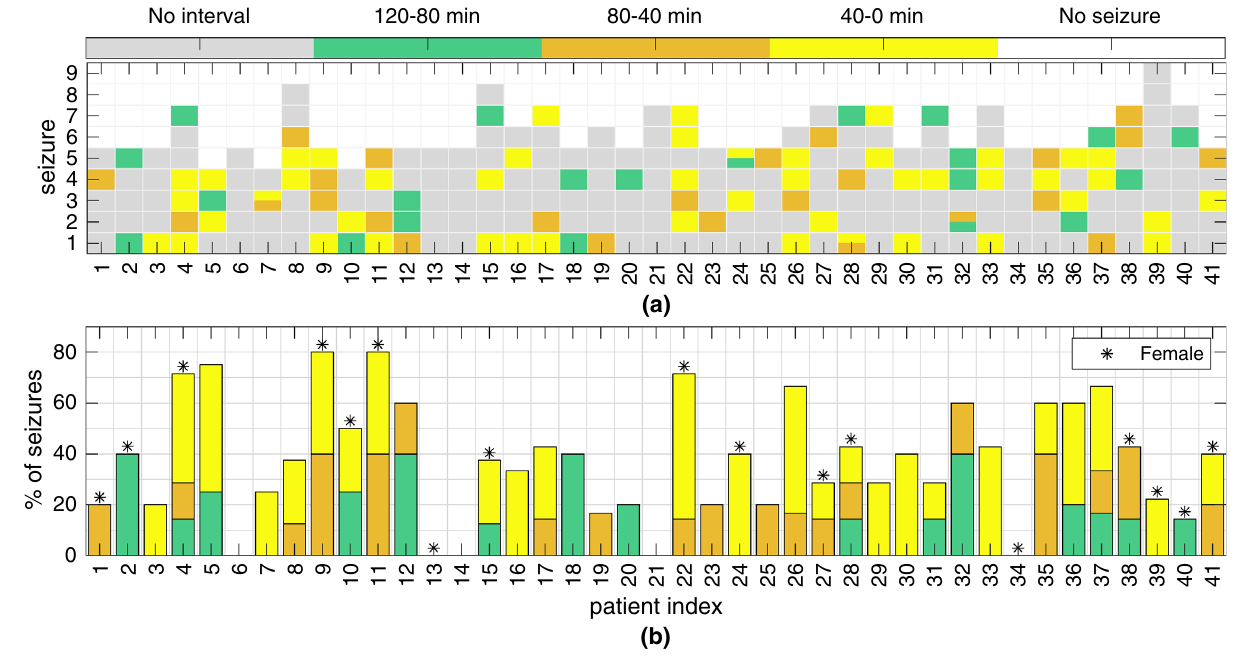
Figure 4. Results of the stratification and selection of clustering solutions based on time continuity and duration. ( a ) Information regarding the existence of clustering solutions for each patient (x-axis) and each seizure (y-axis, in chronological order) for the three different intervals considered: 120–80, 80–40 and 40–0 min before seizure onset (occurring at 0 min). There were four seizures (third seizure in patient 7, fifth seizure in patient 24, first seizure in patient 28, and second seizure in patient 32) for which clustering solutions were found in more than one interval. ( b ) The percentage of seizures for which at least one clustering solution was found is depicted for each patient and each 40-min interval considered. Female patients are indicated by an asterisk. It is important to note that when clustering solutions were found in more than one interval, the interval nearer the seizure was considered for the computation of the percentage for each patient in this